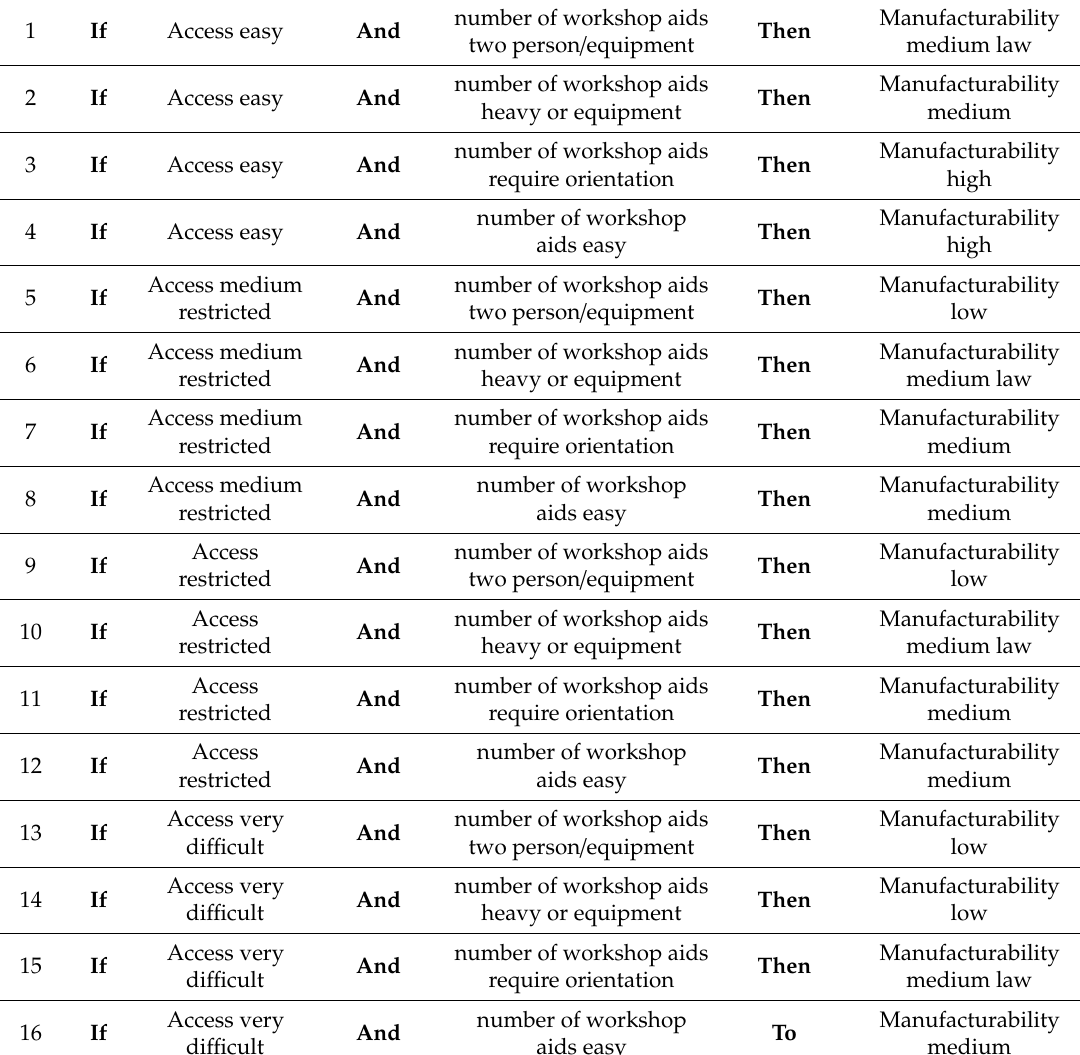
Table 6. Fuzzy rules table for assembly technology—substep